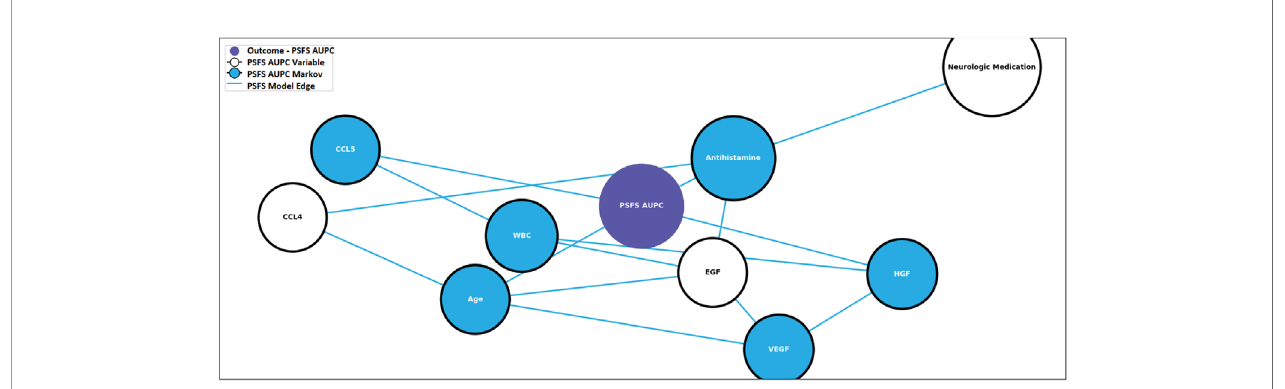
FIGURE 6 | Post-antivenom prognostic model predictive of recovery. PSFS AUPC: Patient-Speci fi c Functional Scale Area Under the Patient Curve, CCL4: C-C motif ligand 4, CCL5: C-C motif ligand 5, ECG: endothelial growth factor, HGF: hepatocyte growth factor, VEGF: vascular endothelial growth factor, WBC: white blood